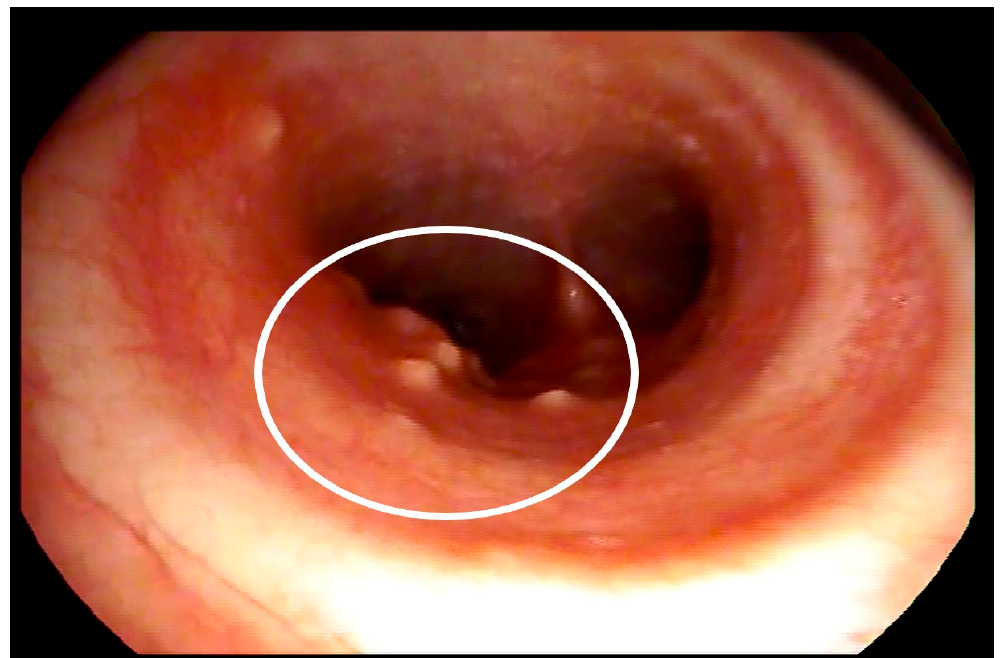
Figure 3. Fibrobronchoscopy showing multiple nodules in the trachea.